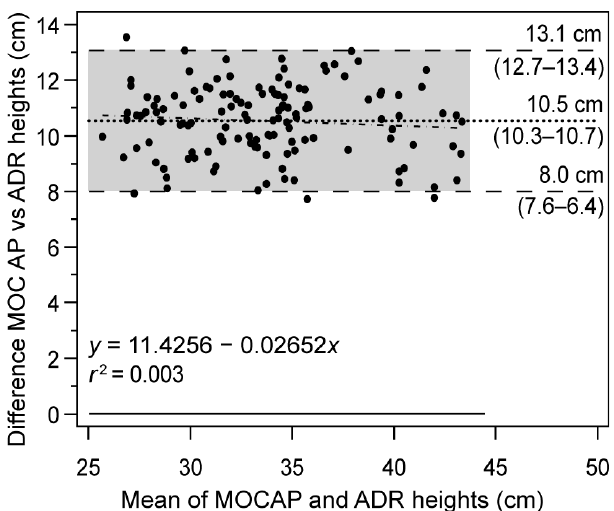
Figure 4. Bland–Altman plot for the study of the validity of the jump height obtained by the ADR jumping photocell versus a MoCAP Optitrack system. Dotted line: mean of the differences (systematic error); shaded areas: confidence intervals for 95% of the mean and LoA; continuous line: the line of perfect agreement (difference 0); plots and dashed line: the regression line of differences; Mean: mean of differences; SD: standard deviation.